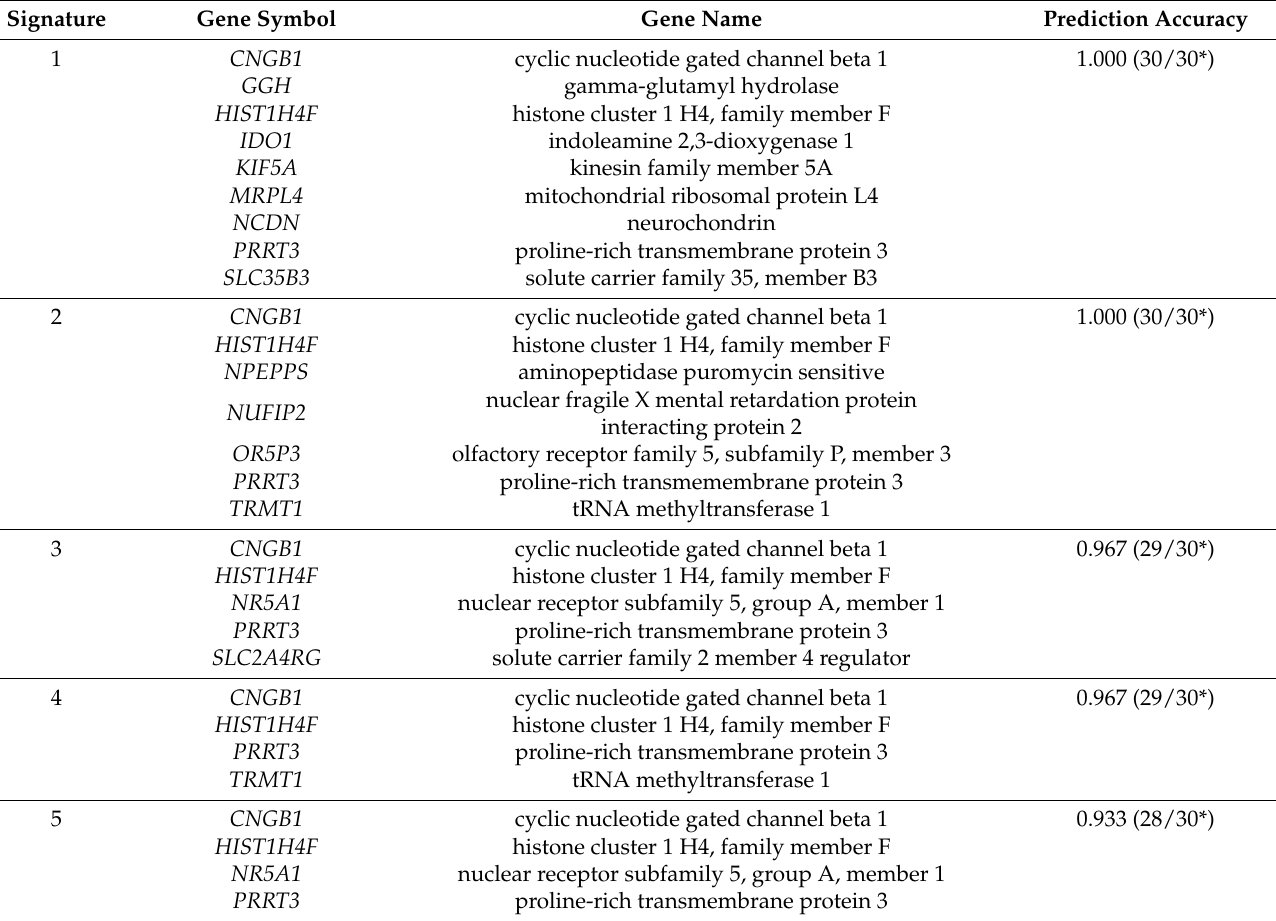
Table 2. List of signatures identified by machine learning algorithm RGIFE with high prediction